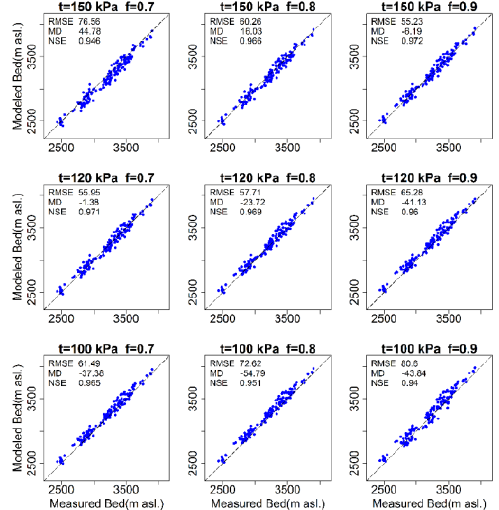
Figure 3. Hillshade views of SRTM-X DEM with the location Figure 4. Comparison between measured (x-axis) ice thickness of topography of six typical glaciers and the survey routes by results from GPR and estimated (y-axis) results from GlabTOP2 GPR and GPS measurements made in the past two years. Black with nine different parameterization schemes. Numbers on top- dots indicate measured points, and black lines denote the left indicate the RMSE, root mean square error; MD, mean measured profiles. deviation; and NSE, Nash Sutcliffe efficiency.